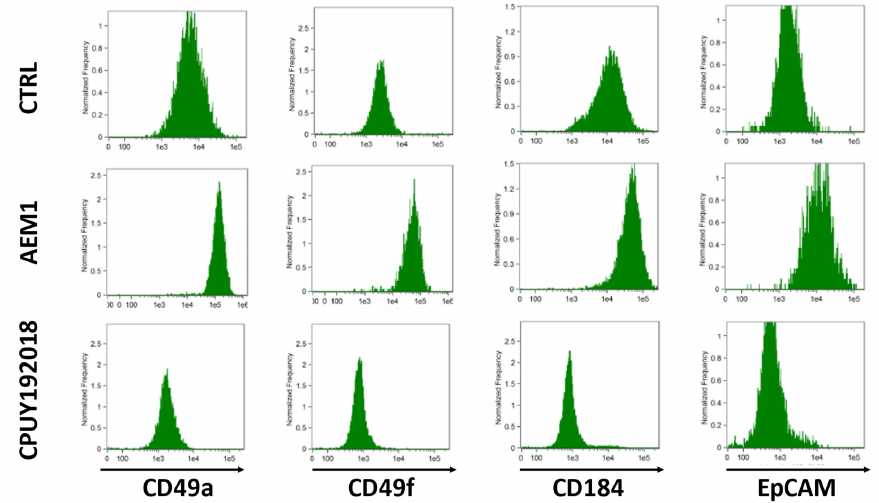
Figure 5. Flow cytometry histograms of confluent HepaRG cells exposed to vehicle (CTRL), 1 μ M AEM1, or 10 μ M CPUY192018 every 24 h for 5 days. AEM1, or 10 µ M CPUY192018 every 24 h for 5 Taken together, these results indicate that NRF2 inhibition may incentivize the dif ‐ ferentiation of bipotent HepaRG, while NRF2 activation may de ‐ differentiate confluent cells.